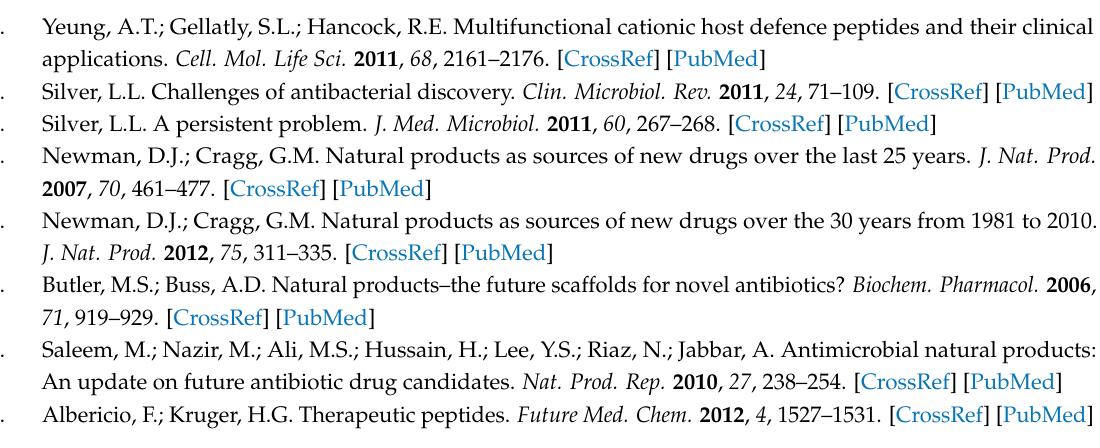
Supplementary Materials: The following are available online. Figure S1: Analysis of the MS-MS spectra of Seq.2. Theoretical MW: 1577.8, Figure S2: Analysis of the MS-MS spectra of Seq.1. Theoretical MW: 1298.5, Figure S3: Chromatographic profile of the three synthetic peptides. Column: Phenomenex C18 Jupiter Proteo. Gradient: 5–70% ACN: H 2 O. Detection: 220 nm., Table S1: Alignment of the ion with m / z : 1298.72 with the amino acid sequences of the six ocellatins reported from L. latrans